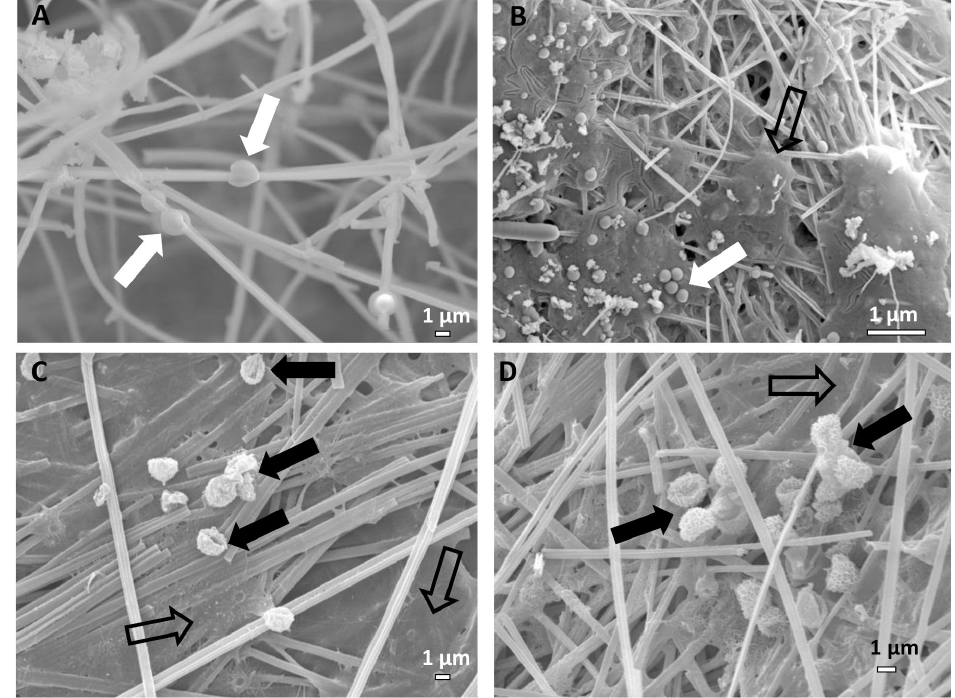
Figure 4. Field emission scanning electron microscopy (FESEM) images of moonmilk sample (Bella 1) from Bellavista Cave, depicting: ( A , B ) Needle-shape calcite fibers with coccoid-like microbial cells with smooth surfaces; ( C , D ) Actinobacteria-like cells with spiny surface ornamentation associated with moonmilk. Open arrows show EPS. White arrows indicate coccoid-shaped cells with smooth surfaces. Black arrows show Actinobacteria-like cells. Black open arrows show the matrix of EPS. Magnifications for ( A – D ) are 3000, 1500, 4500 and 4500,